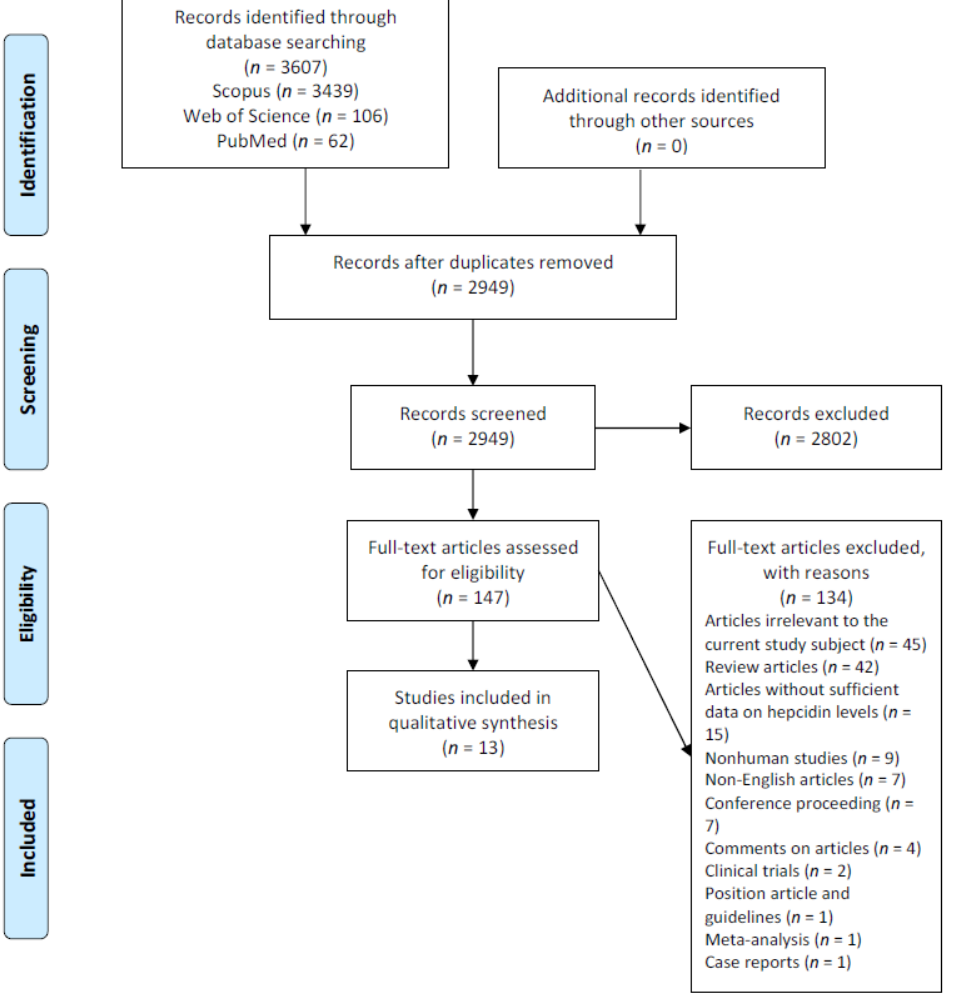
Figure 1. Preferred Reporting Items for Systematic Reviews and Meta-Analyses (PRISMA) flow diagram.